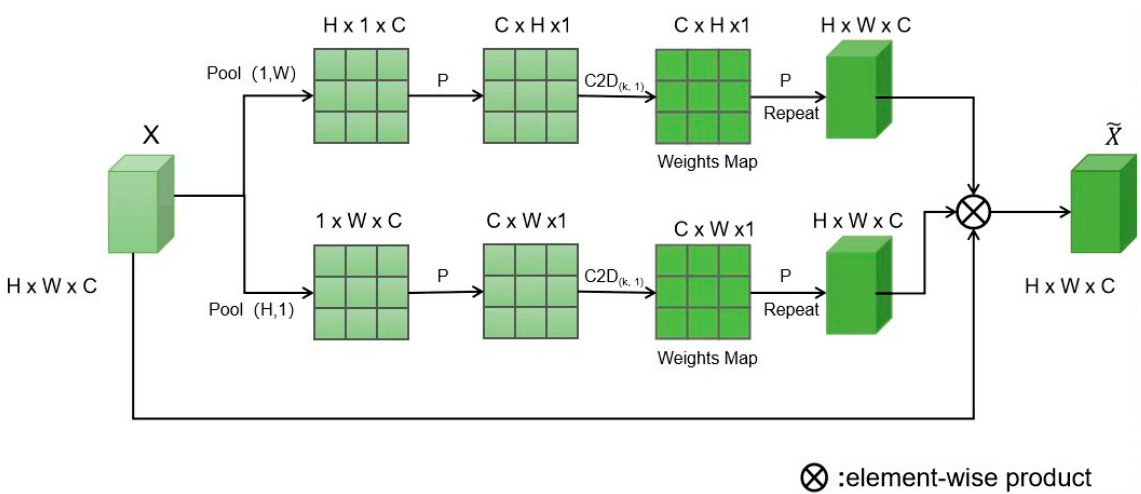
Figure 4. Vector Pooling A tt ention (VPA)